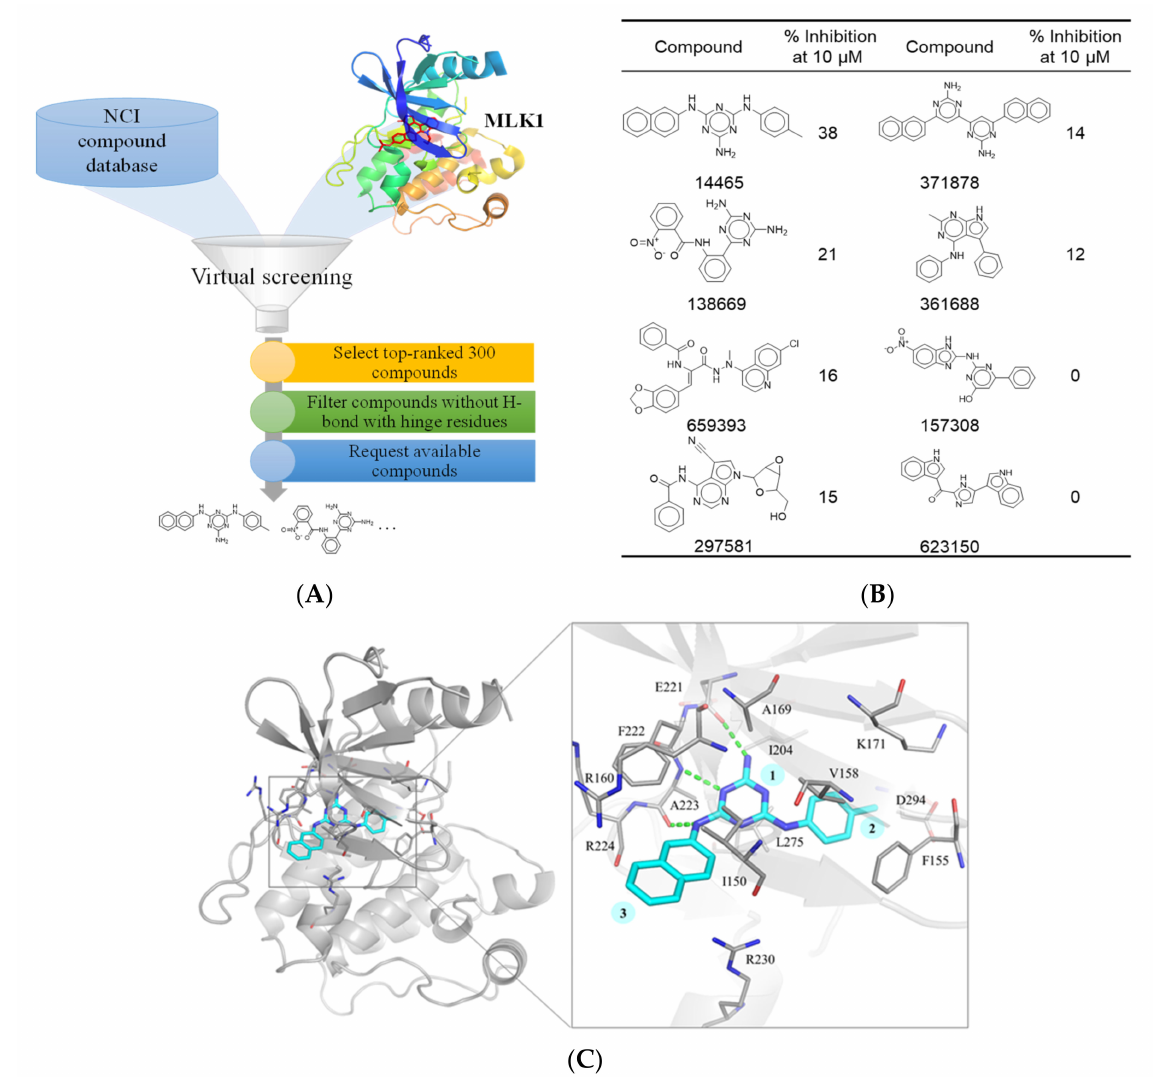
Figure 2. Selection of MLK1-targeting inhibitors. ( A ) Workflow of the structure-based virtual screening approach. The NCI compound library was virtually screened against the MLK1 structure (PDB ID: 3DTC). The resulting compounds were